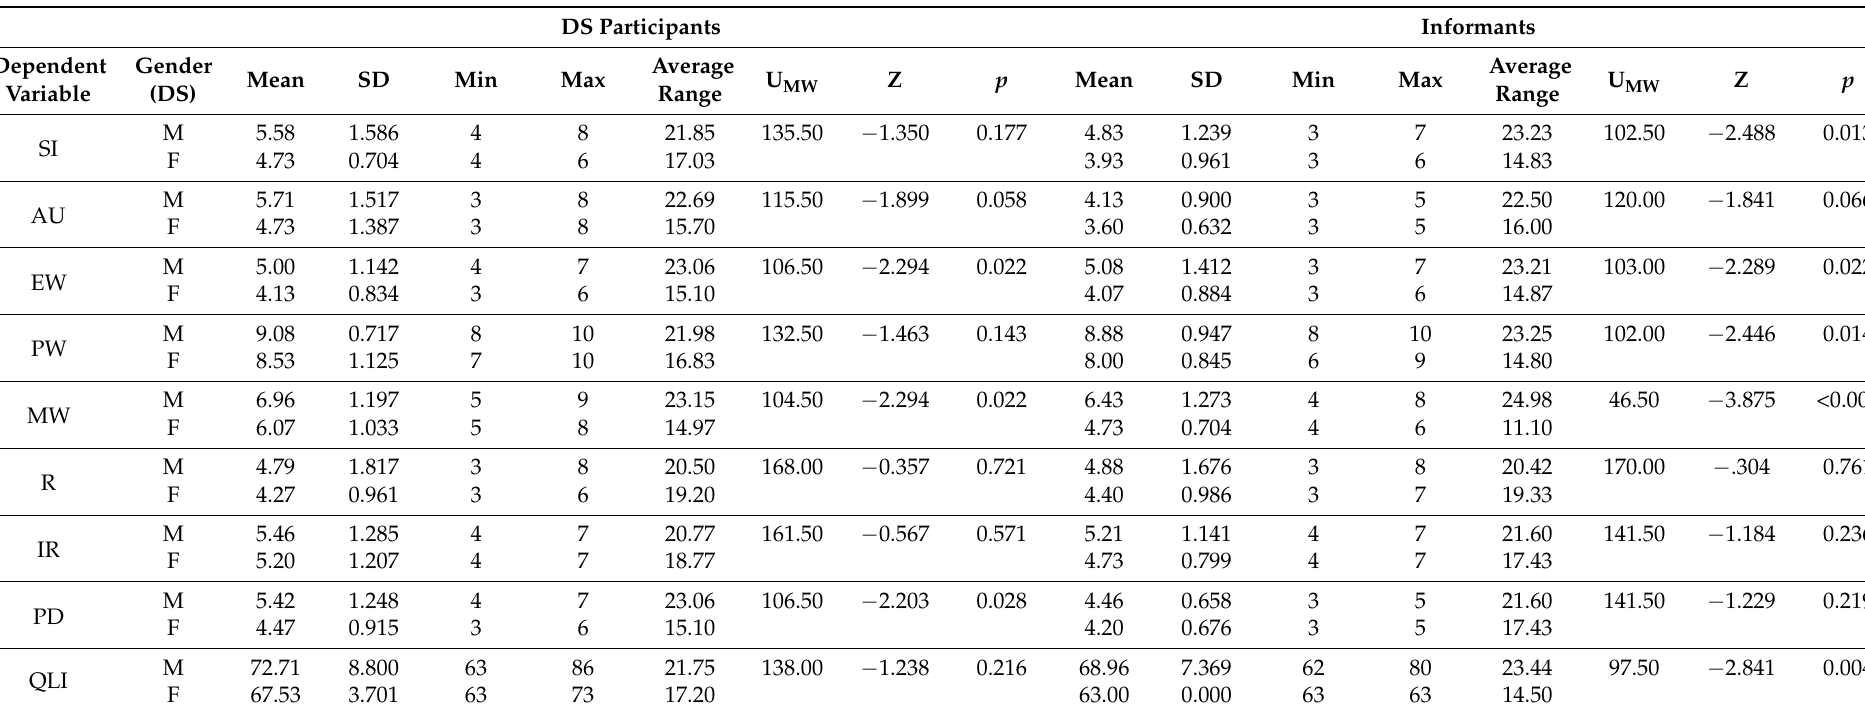
Table 4. Mann–Whitney U tests for independent variables of the study with respect to gender for the subgroup of participants with DS (men n = 24; women n = 15) concerning self-perception and perception of informants ( n =